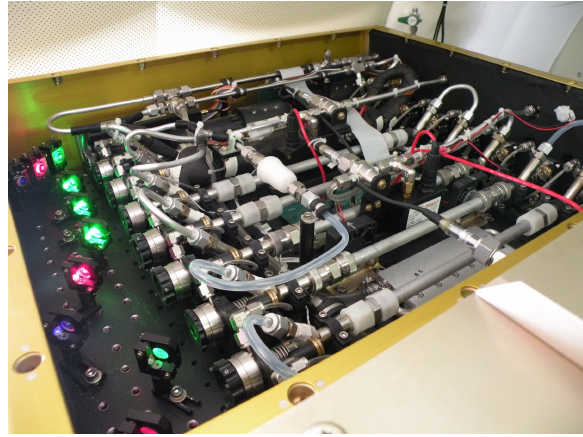
Figure A2. The eight separate ring-down cells in the CRD instru-